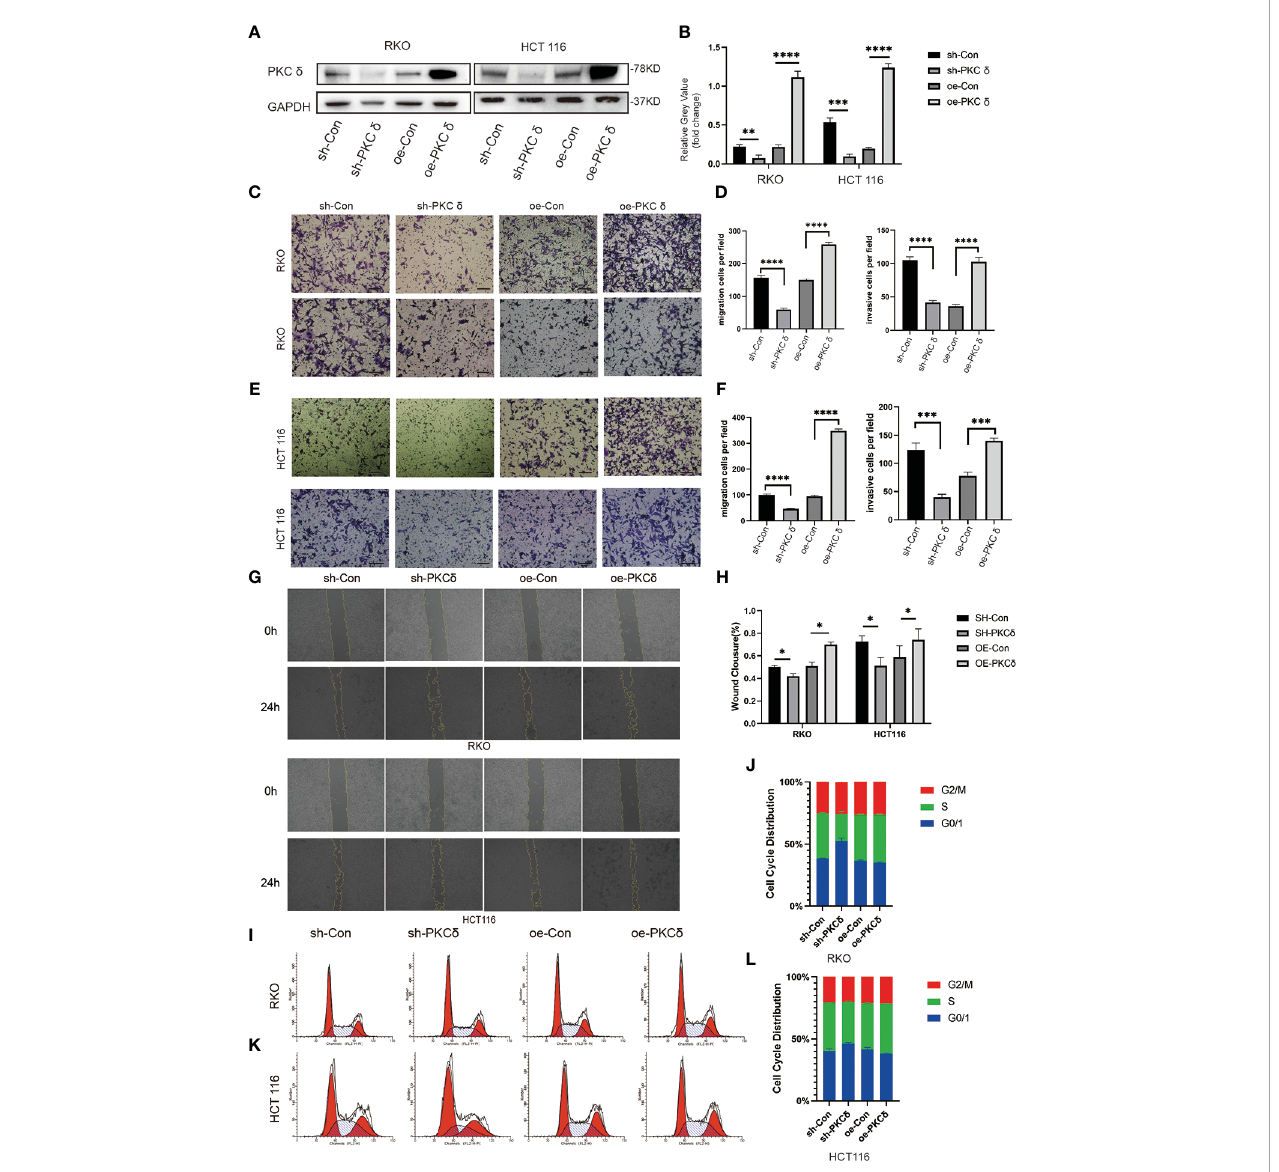
FIGURE 3 PKC d promotes the invasion and migration of CRC cells (A) PKC d overexpressed and knockdown and the corresponding negative control in RKO and HCT116 cells, determined by Western blots. (B) Columns were used to quantify the protein expression levels in (A) relative to GAPDH. (C) Cell migration and invasion assay to detect the effect of PKC d on the invasion and migration of RKO cells. (D) Columns were used to quantify the migrated and invasive cells in (C) . (E) Cell invasion and migration assay to detect the effect of PKC d on invasion and migration of HCT116 cells. (F) Columns were used to quantify the migrated and invasive cells in (E) . Wound-healing assay to the effect of PKC d on the lateral migration ability of RKO and HCT116 cells (G) . (H) Columns were used to quantify the lateral migration cells in (G) . Flow cytometric analysis to detect the impact of PKC d cell cycles of RKO (I) and HCT116 cells (K) . Columns were used to show the cell cycles of RKO (J) and HCT116 (L) cells.Scale bar. Scale bar: 20µm.*p < 0.05, **p < 0.01, ***p < 0.001, ****p <